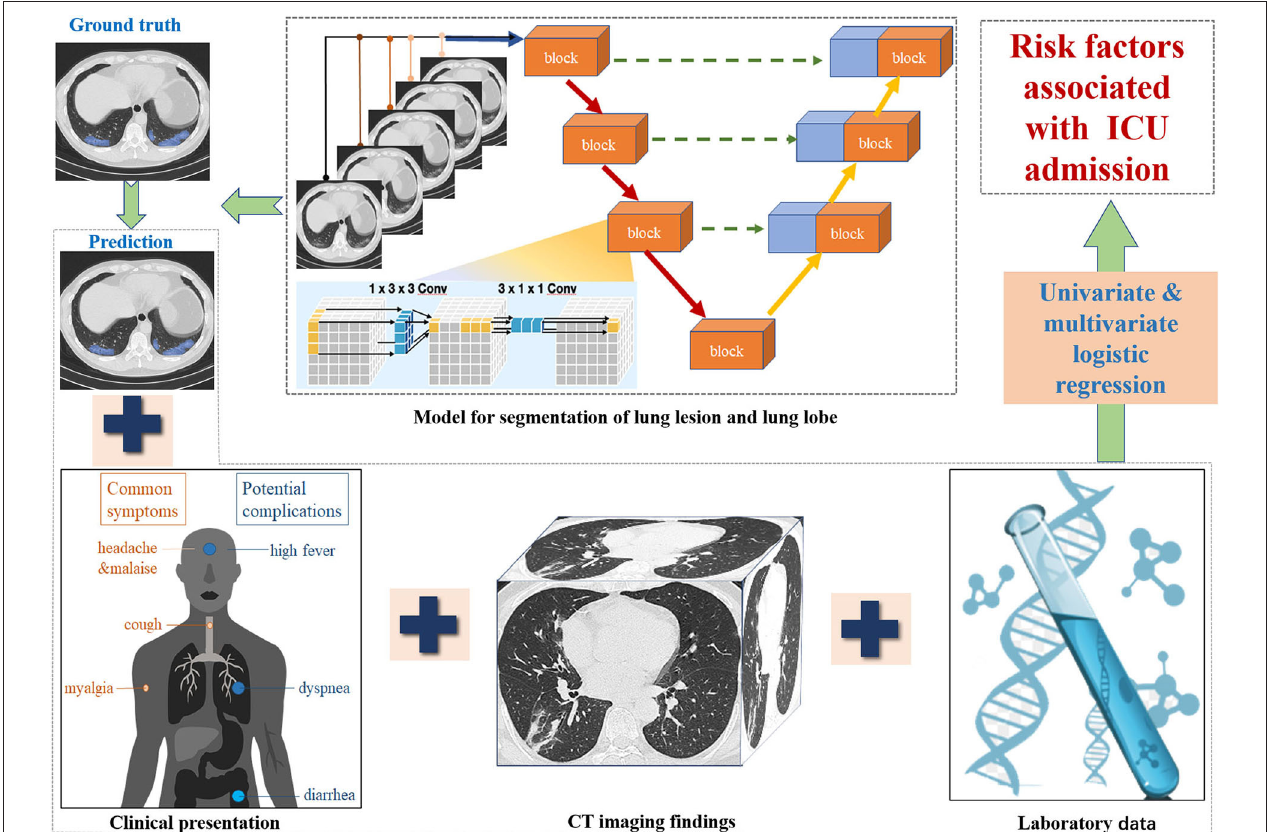
FIGURE 3 | Workflow of ICU prediction in COVID-19